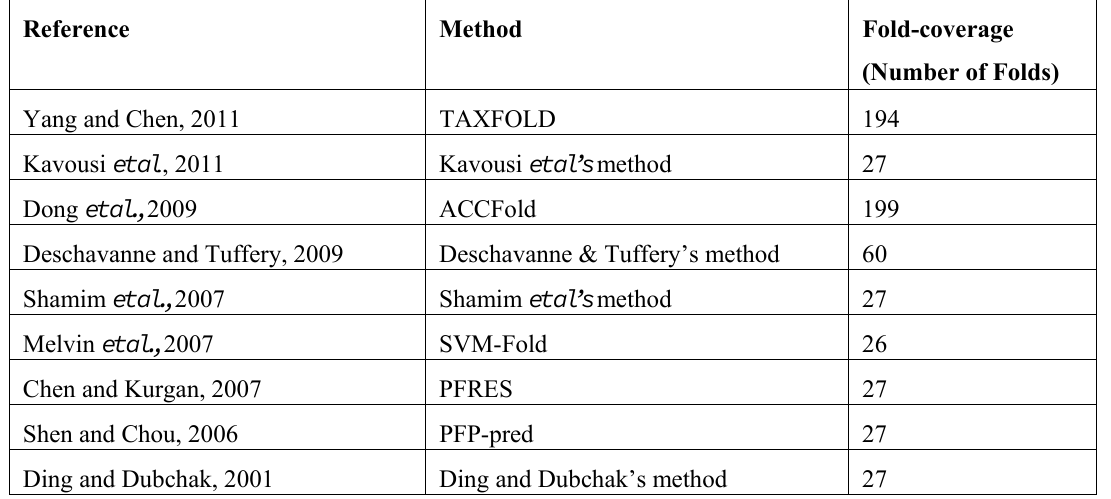
Table 1: Fold-coverage (Number of protein folds covered) of different taxonomic fold recognition